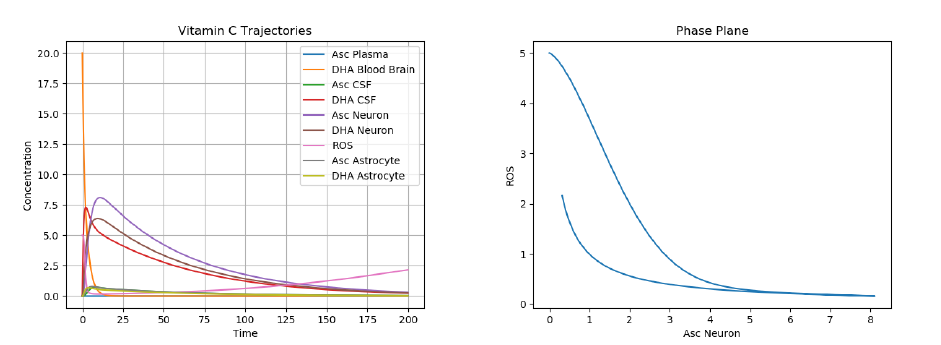
Figure 5. Dynamics of AA, DHA, and ROS during Stroke with Delayed High Dose DHA Treatment